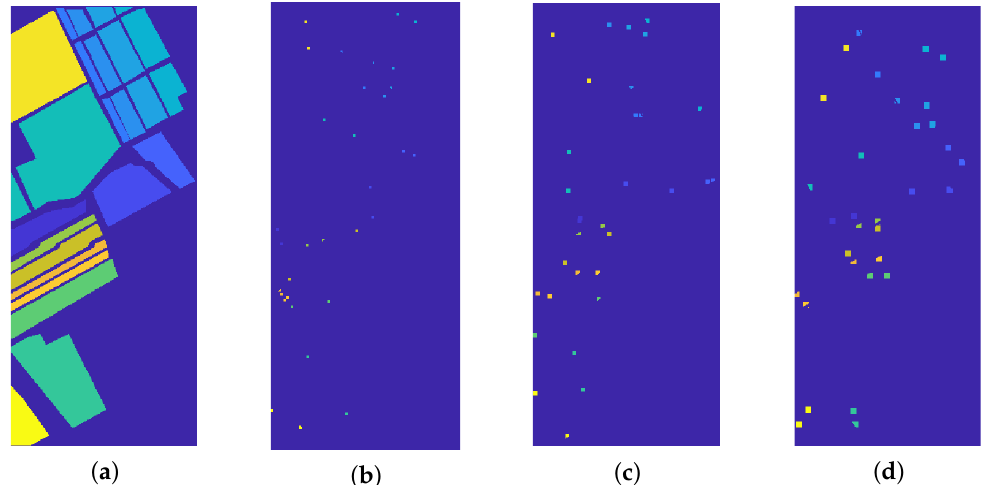
Figure 6. ( a ) Ground truth labels. ( b – d ) Random seeds for the proposed procedure, chosen among the ground truth mask. From left to right: square seeds of dimension 3, 5, and 7 pixels. The squares are clipped in order to refer to the correct region.